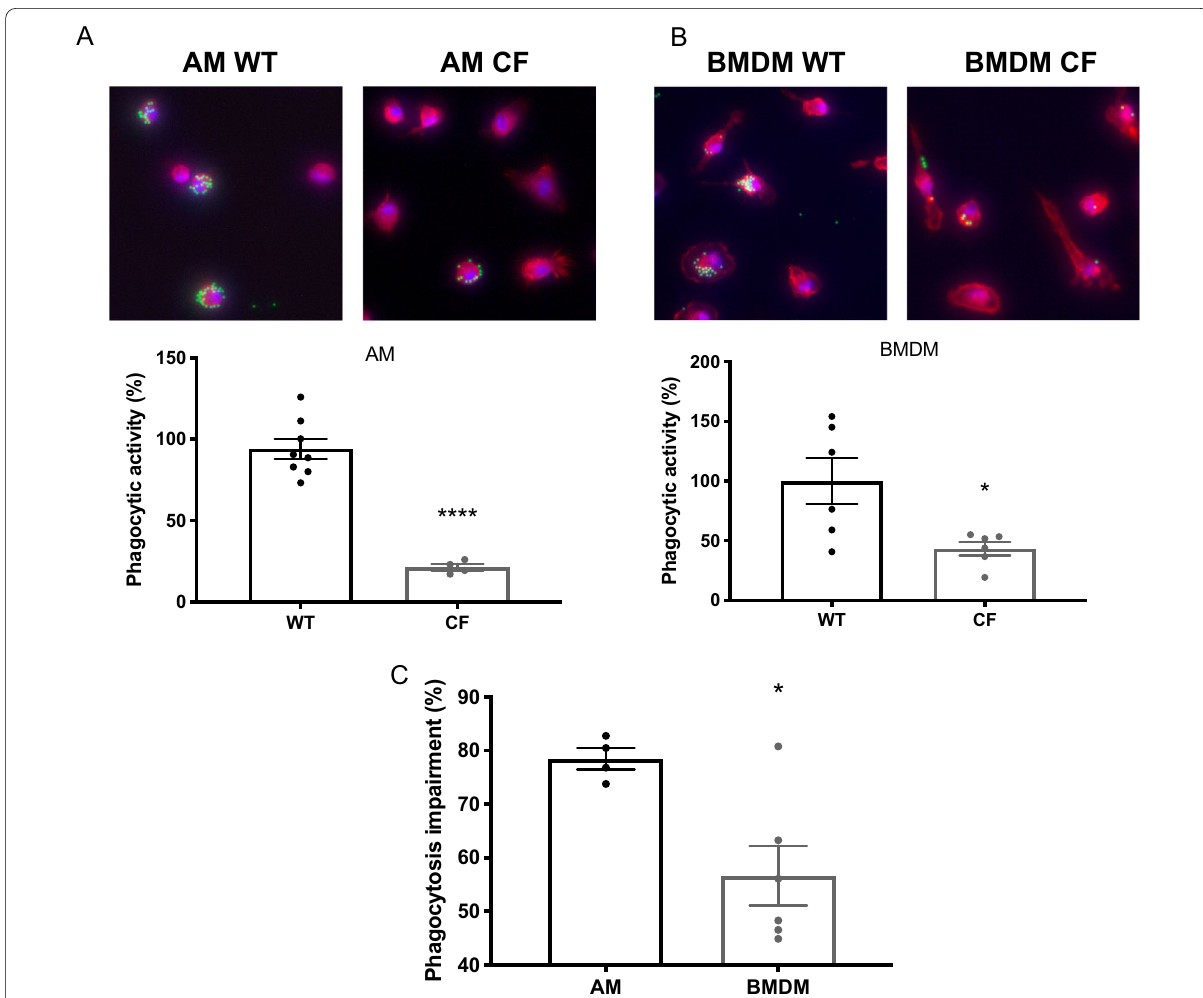
Fig. 4 Phagocytic function is compromised in macrophages isolated from CF mice. Bone marrow derived macrophages (BMDM) and alveolar macrophages (AM) isolated from C57BL/6 mice (WT, n 3 mice) and CFTR − / − mice (CF, n 3 mice) were cultured. Phagocytosis assay was = = performed on A. AM and B. BMDM by incubating cells with FITC-labeled latex mini-beads (green stain) for 1 h and then staining with DAPI (blue nuclear stain) and phalloidin (red cytoskeletal stain) to visualize the amount of phagocytosed beads per cell. Fluorescent micrographs were quantified and the phagocytic ability of macrophages was represented as a percent phagocytic activity normalized to WT control group. Each value represents mean SEM of three independent experiments for each group. *, P < 0.05, ****, P < 0.0001, compared to control groups. C To determine ± if the magnitude of phagocytosis impairment in CF macrophages is similar between the alveoli and bone marrow macrophages, the phagocytosed beads for AM and BMDM isolated from CF mice were compared to their WT counterparts and expressed as the percent of phagocytosis impairment of the WT macrophages. Each value represents mean SEM of three independent experiments for each group. *, P < 0.05 compared to AM group. ± Unpaired t-test was used for comparison between two